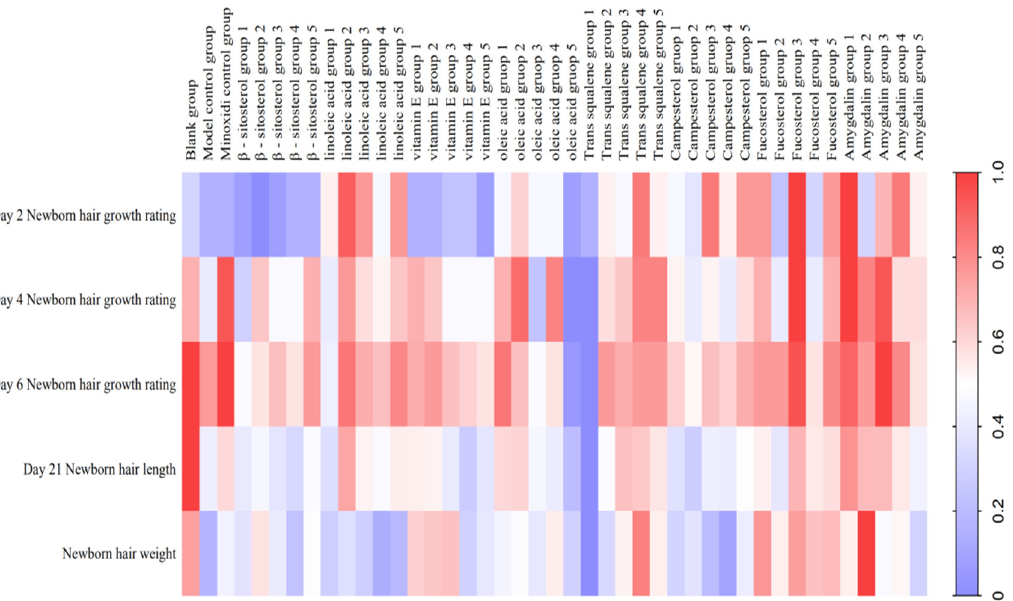
Figure 11. Heat map of the degree of influence of components in the kernel of P. mira on KM mice after depilation induced by sodium sulfide.